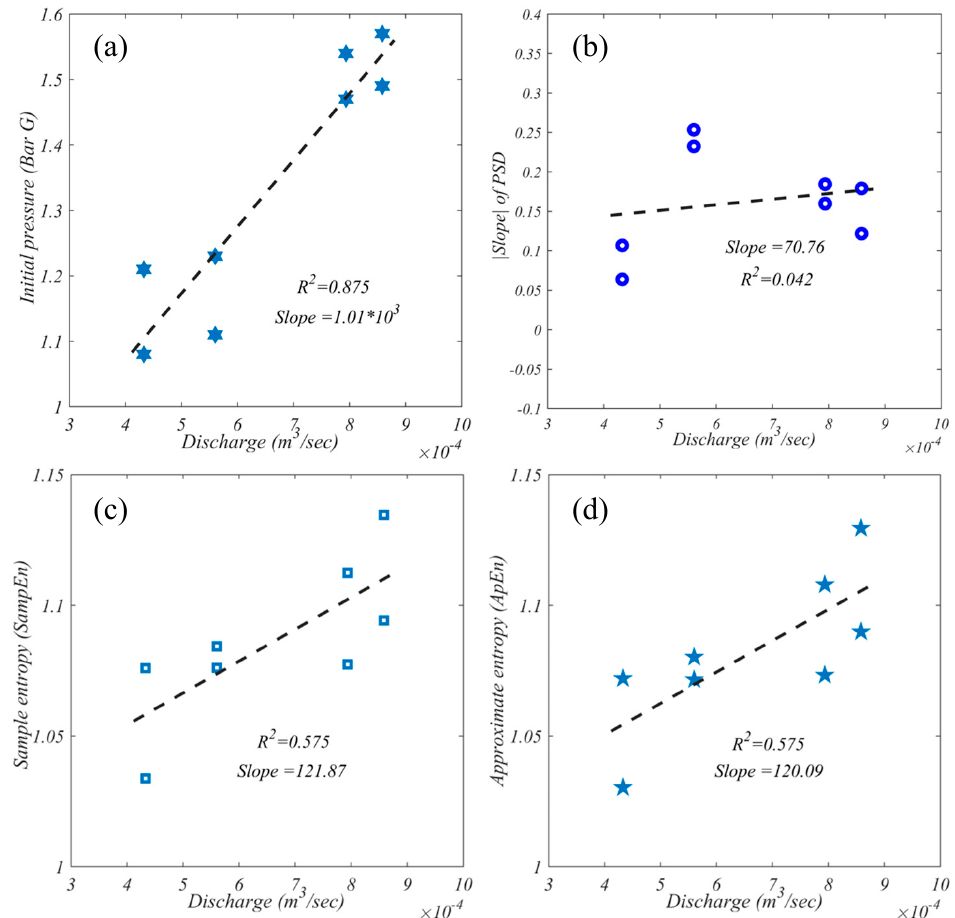
Figure 8. Response of discharge, Q (m 3 /sec), on ( a ) static gauge pressure, ( b ) absolute value of β , ( c ) sample entropy SampEn , and ( d ) approximate entropy ApEn